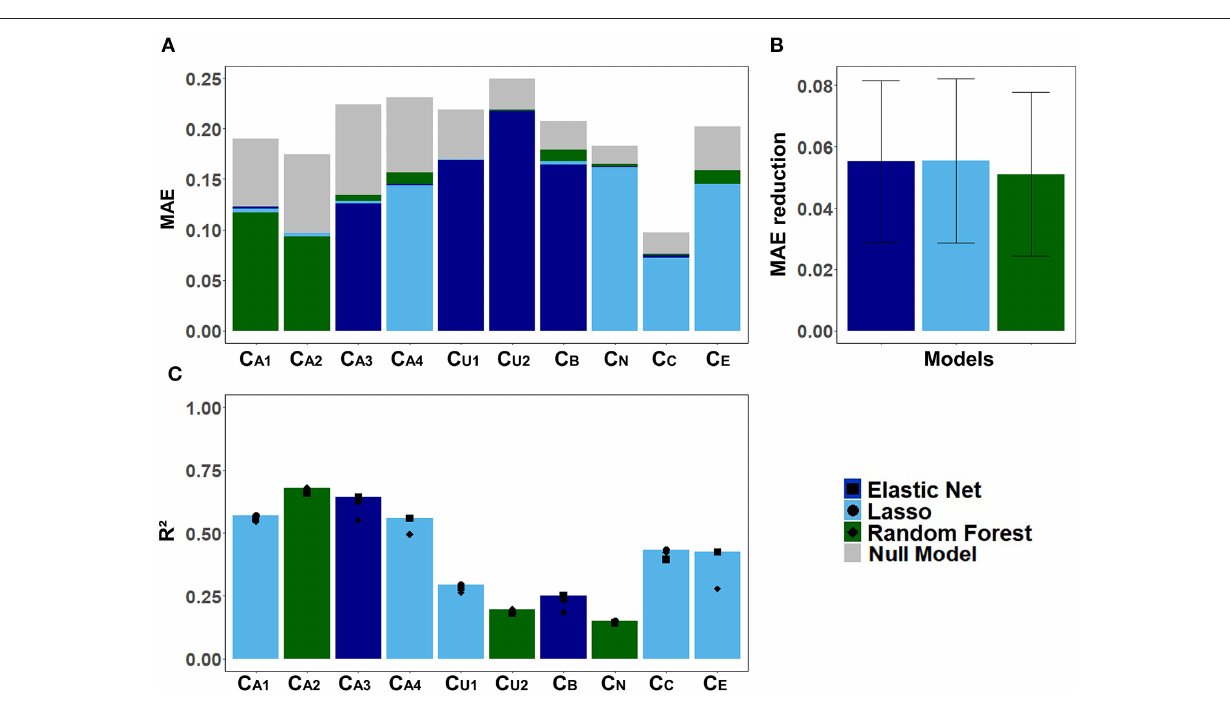
FIGURE 6 | Model-specific predictive performance accuracy for the CAFPAs on the test set, averaged over multiple imputed data sets. Different models are color-coded. (A) Mean absolute error (MAE) for each CAFPA. indicates the predictive performance of the null model, and the foremost bar color denotes the model with best predictive performance. (B) Mean and standard deviation of the MAE reduction as compared to the null model, averaged over CAFPAs. (C) Coefficient of determination ( R ² ) for each CAFPA. The depicted bar color indicates the model with the best predictive performance. The symbols denote the performance of the respective comparison